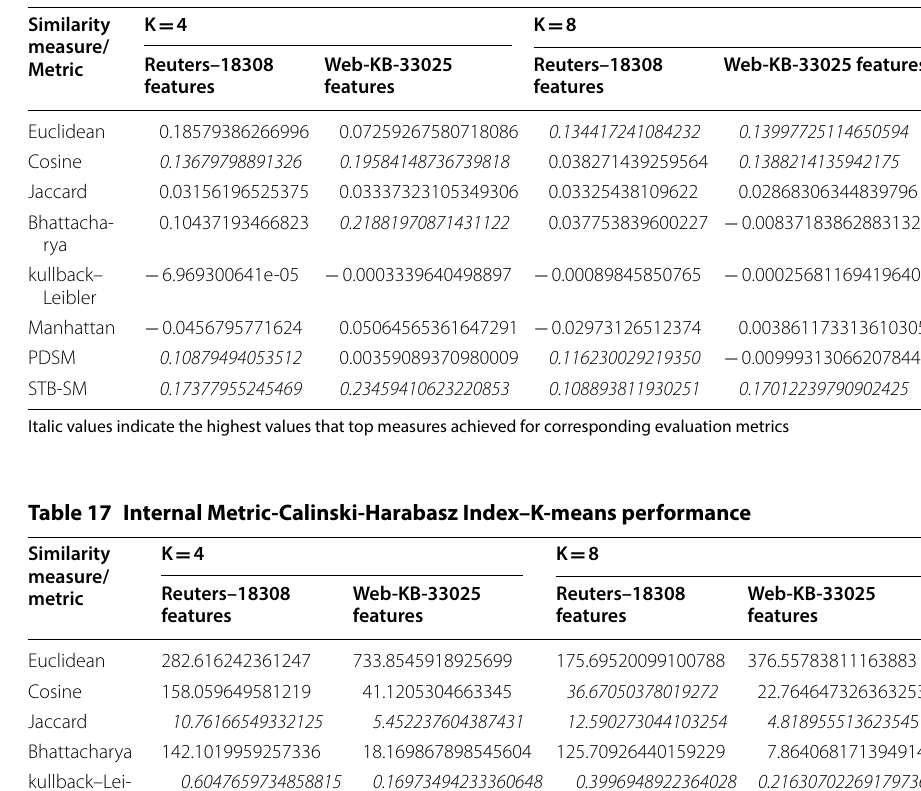
Table 16 External metric—Rand index‑K‑means performance